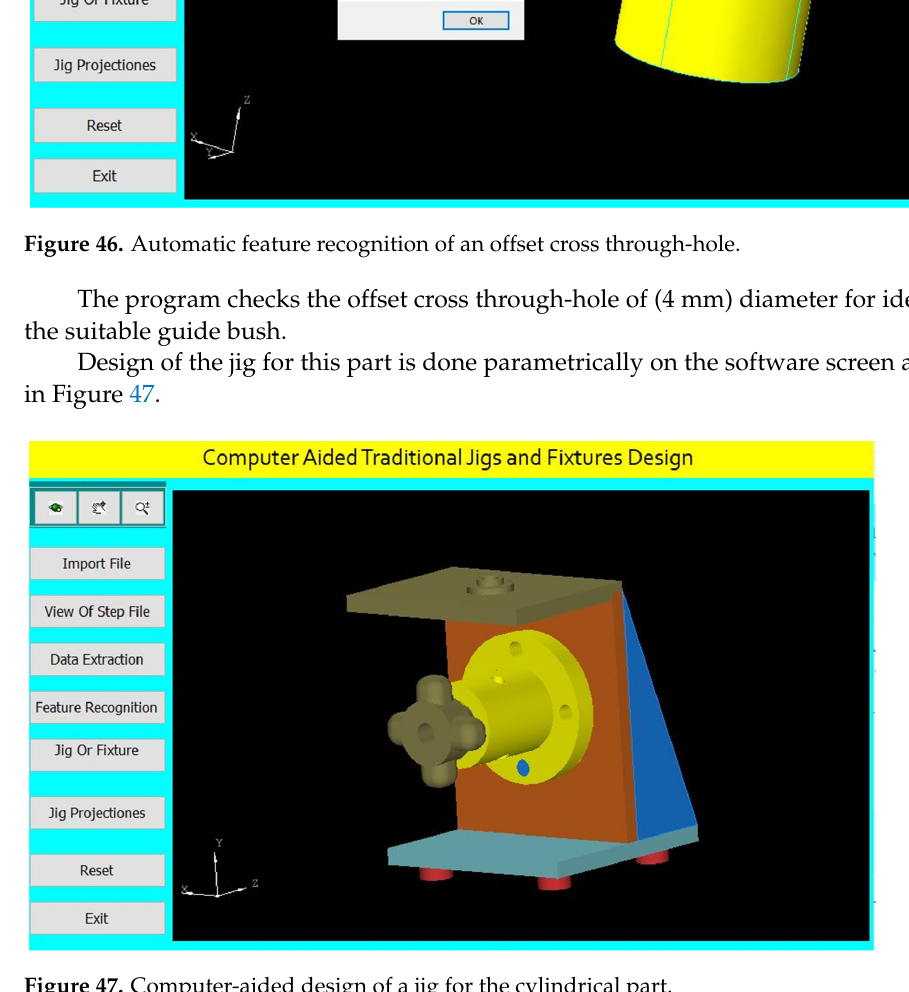
Figure 48. The jig views. A Jig Design for a Cylindrical Part with an Inclined Cross Through-Hole Figure 49 shows the drawing of the cylindrical part with an inclined cross through-hole, and Figure 50 shows the main components of the required jig design which will be done through the following steps: The drawing and isometric of a cylindrical part prepared using SolidWorks soft- ware as shown in Figure 49. The file is saved in STEP-AP203 file format.